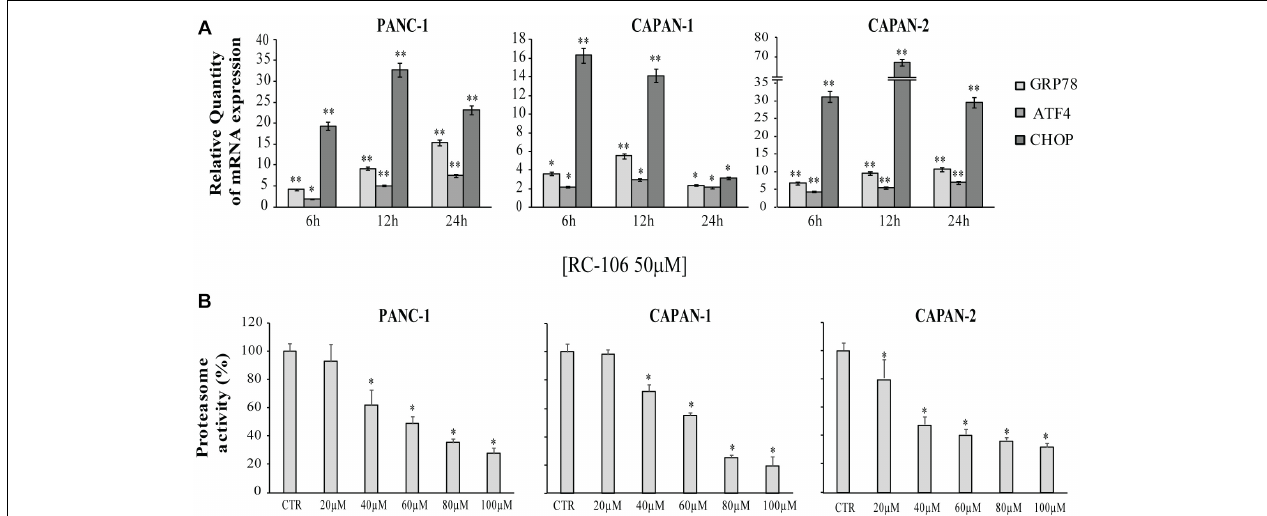
FIGURE 4 | Relative Quantification (RQ) of the ER stress and UPR marker genes. (A) GRP78, ATF4, and CHOP mRNA expression levels were measured after a treatment with RC-106 50 µ M for 6,12, and 24 h. Analysis were performed with Real-Time PCR. RNA expression was normalized to GAPDH and HPRT-1. In each time point tested the RNA gene expression was relative to the corresponding untreated control (RQ = 1). Values are the mean ± SD of three independent experiments. ( ∗ P < 0.05 vs. CTR; ∗∗ P < 0.01 vs. CTR). (B) Graphs represent the proteasome activity of PANC-1, Capan-1, and Capan-2, treated with increasing concentration of RC-106 (20–100 µ M) for 24 h. Data are expressed as the average percentage ± SD of at least three independent experiments and are compared to untreated controls (CTR 100%; ∗ P < 0.05 vs. CTR).